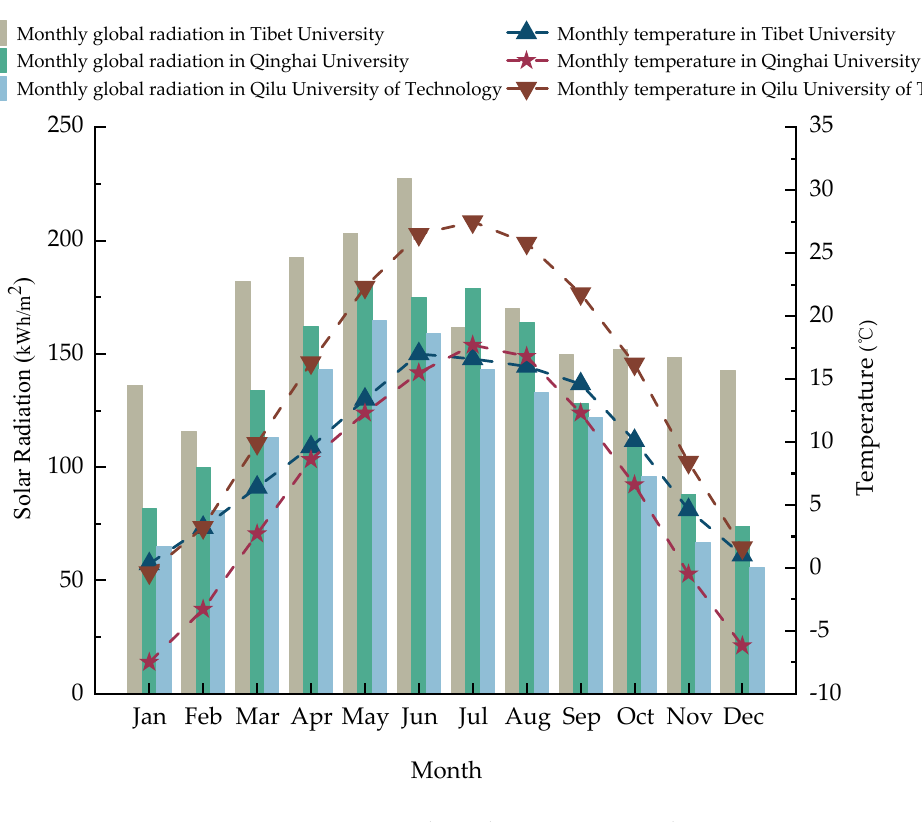
Figure 5. Main meteorological parameters in three university campuses (data source from Reference [26]).